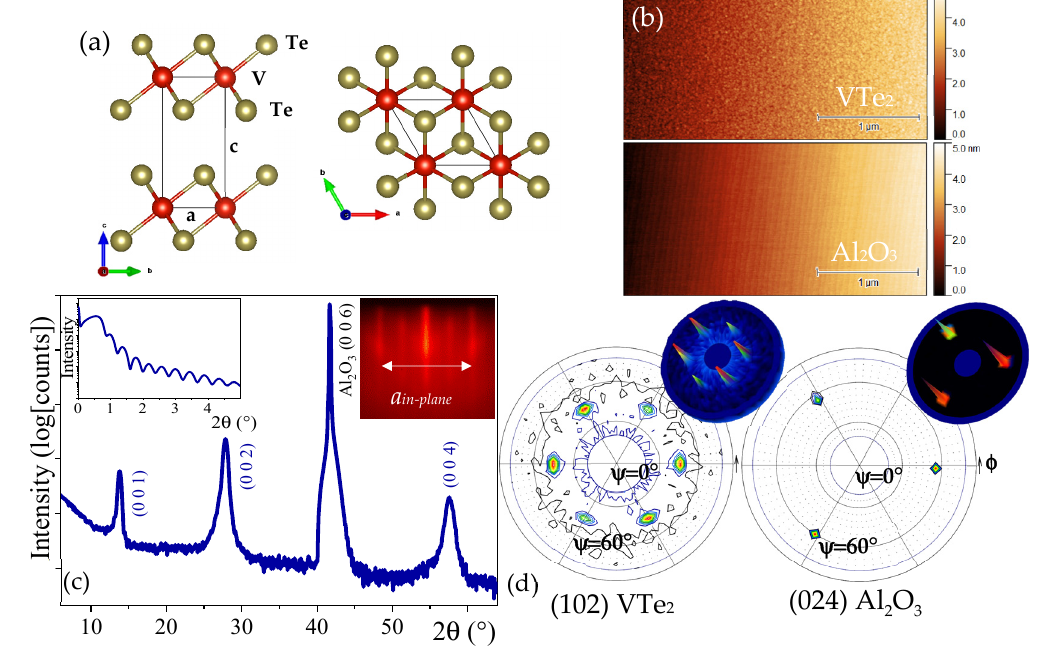
Figure 1. ( a ) Schematic side- and top-view of the crystal structure of 1T-VTe 2 . ( b ) AFM image of 5 nm 1T-VTe 2 thin film ( top ) and Al 2 O 3 (001) substrates ( bottom ). Both show a smooth terrace termination. ( c ) XRD pattern of a VTe 2 thin film deposited on an Al 2 O 3 (001) substrates. Miller indices of the corresponding planes are indicated. Insets: XRR reveals oscillations that correspond to a thickness of 15.7 nm and RHEED with streaks corresponding to a = 3.66 Å. ( d ) Pole diagram measured at 2 θ = 39.6° and 2 θ = 52.6° corresponding to the (102) and (024) crystalline plane of VTe 2 and Al 2 O 3 , respectively.